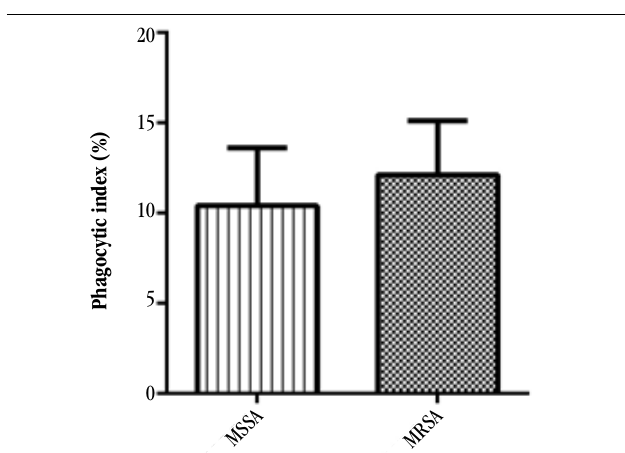
figurE 2 – PI of alveolar macrophages from adult Wistar rats for MSSA and MRSA systems. Values expressed as mean ± standard error ( n = 20) PI: phagocytosis index; MSSA: methicillin sensitive S. aureus ; MRSA: methicillin resistant S. aureus